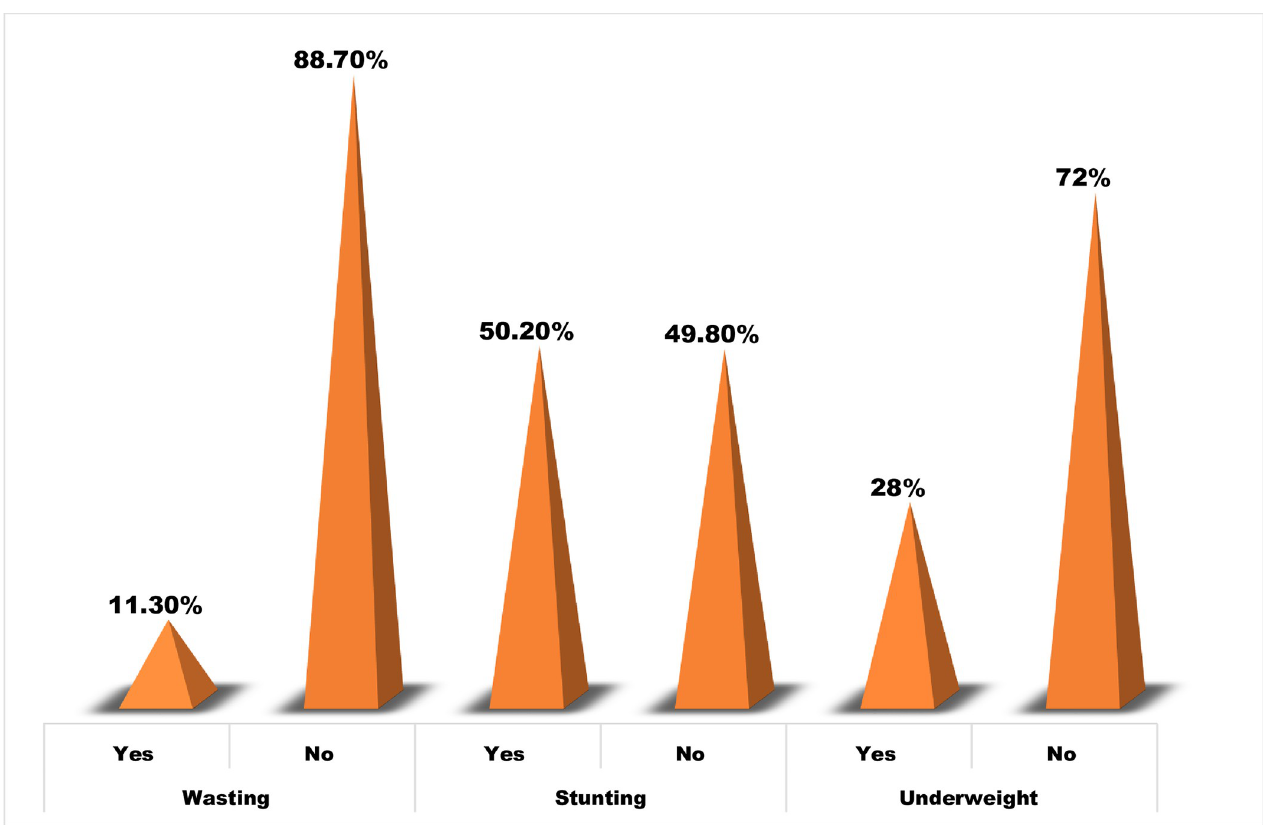
Fig 1. Prevalence of under-nutrition among children aged 6 to 59 months in Menz Gera Midir District, Northeast Ethiopia, in 2021 (N = 432).